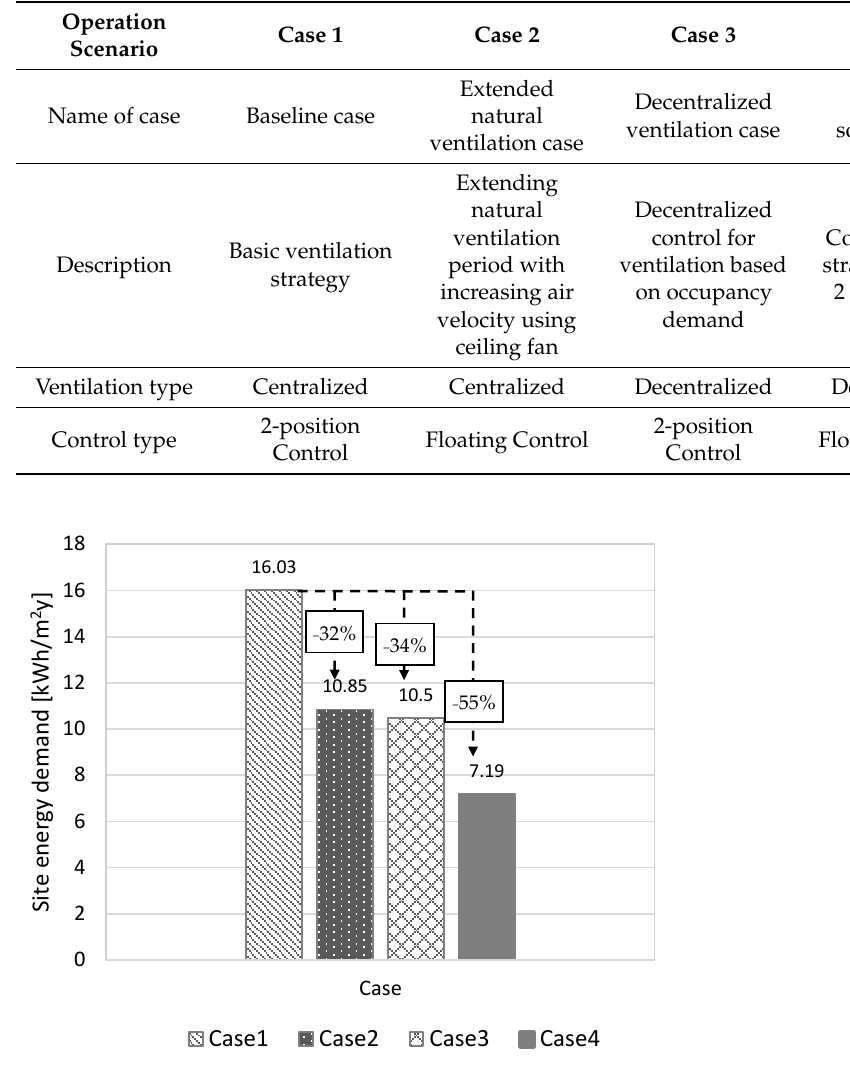
Table 5. Simulation cases description.